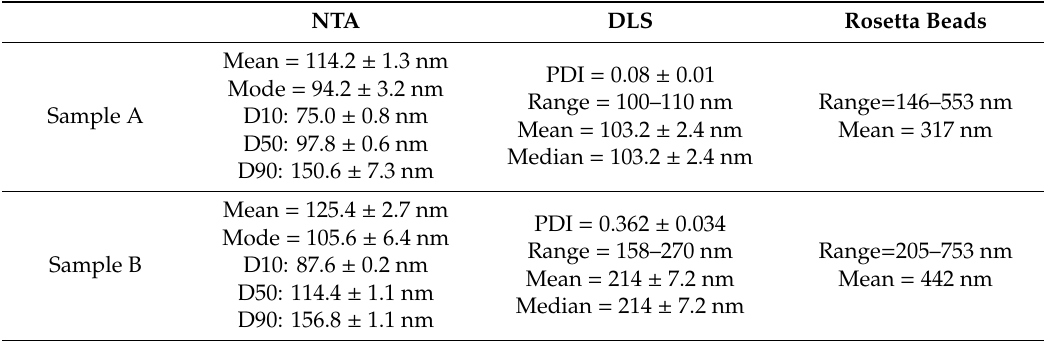
Table 1. Liposomes